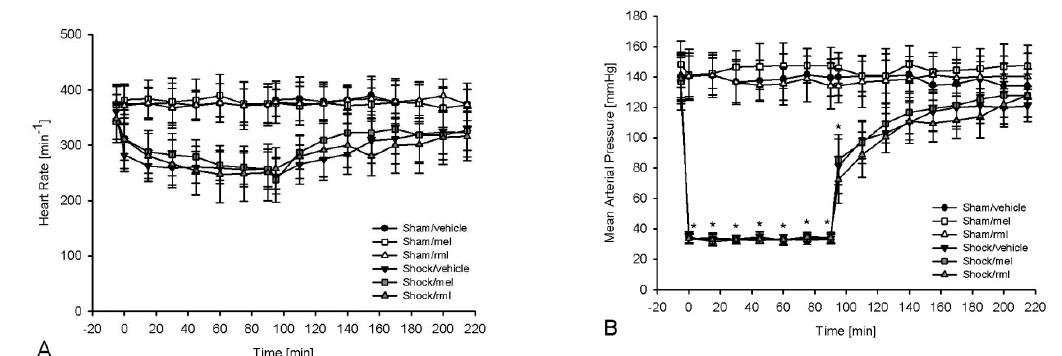
Figure 2. The recovery of the heart rate ( A ) and mean arterial pressure ( B ) was equivalent in all shock groups after resuscitation. No significant difference was detected between groups that underwent a hemorrhage. An asterisk (*) indicates p < 0.05 vs. baseline values. Data are expressed as mean ± SD ( n = 8). rml = ramelteon; mel = melatonin. Table 1. Blood gas analysis.